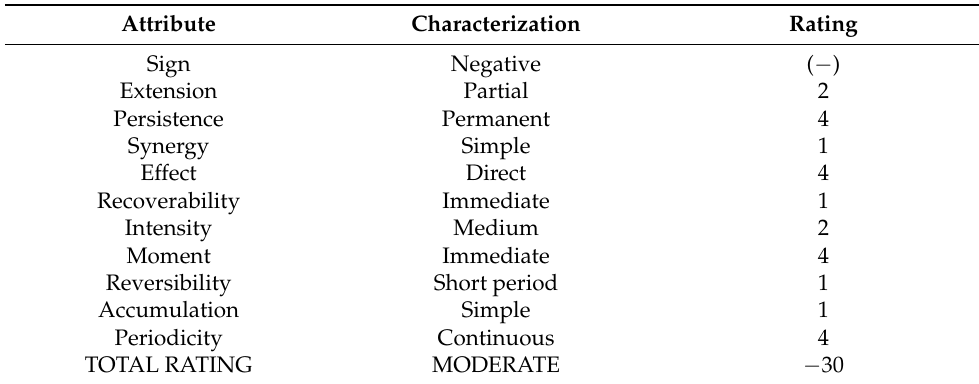
Table 7. Assessment of the impact of EMF on marine